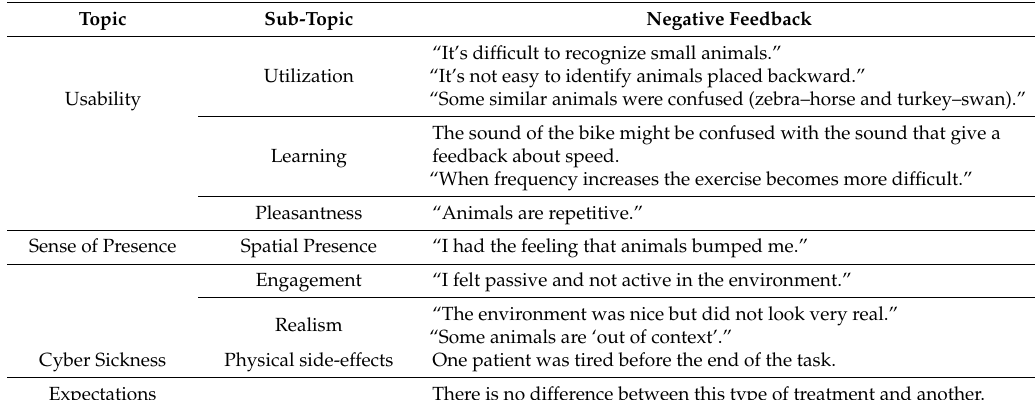
Table 6. Negative feedback from formative